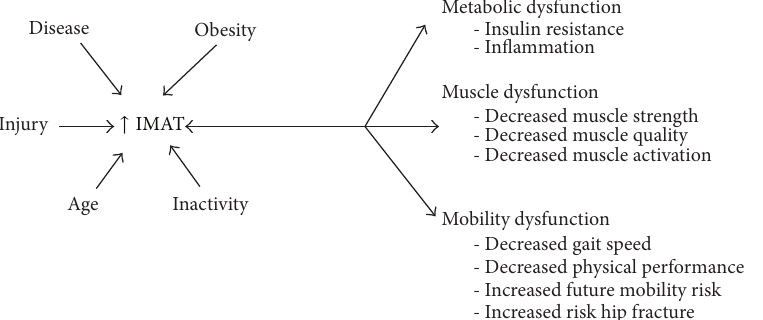
Figure 2: Muscle injury, obesity, age, disease status, and inactivity are all factors that are associated with increased levels of IMAT. Increased levels of IMAT may also lead to a myriad of metabolic, muscle, and mobility